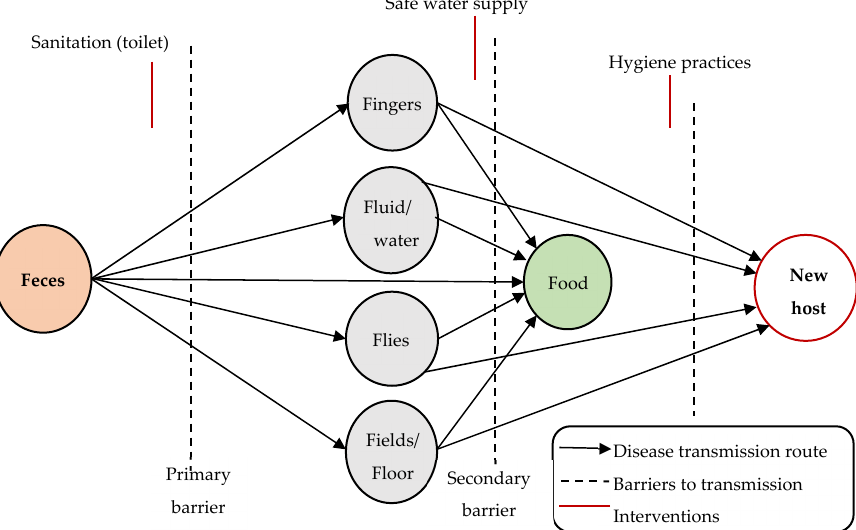
Figure 1. Diarrhea transmission pathways through polluted water sources. Source: Adapted from [39].